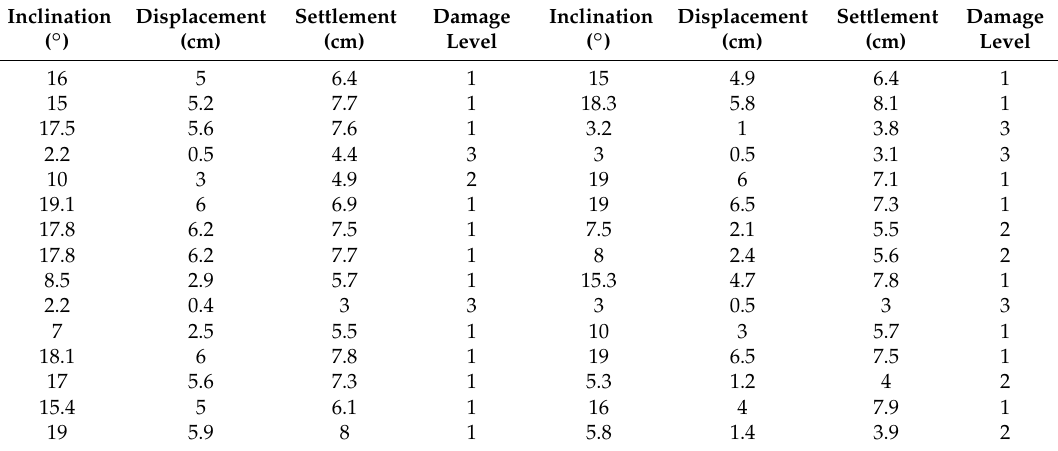
Table 5. The data sets for validation [24].